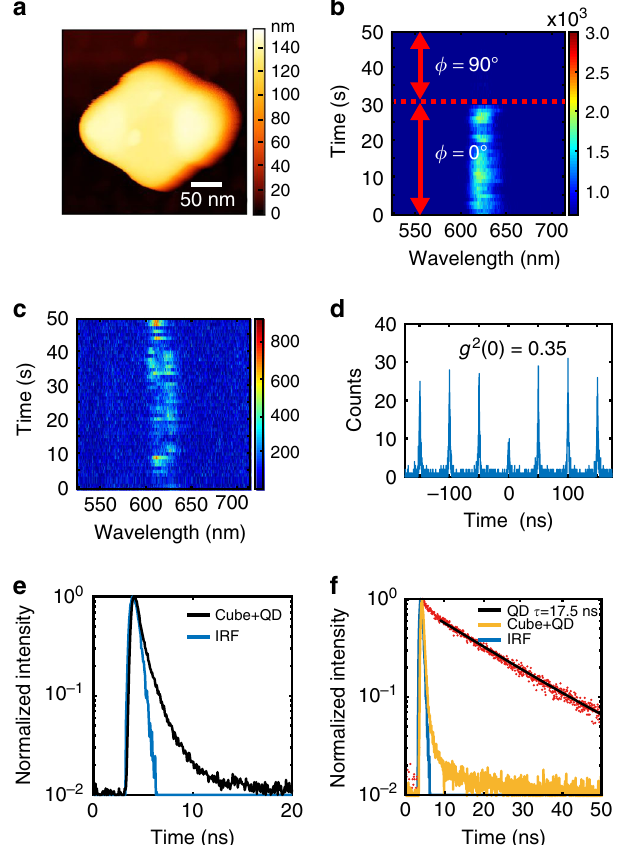
Fig. 8 Hybrid nano-emitters in the single photon regime. a AFM image of a nanocube-based hybrid nano-emitter. The polymer lobes contain a single or a few QDs. b , c PL spectrum time trace of t = 50 s excited by linearly polarized laser along ϕ = 0° at 405 nm. In b , at time t = 32 s, the polarization direction is rotated to ϕ = 90°. d g (2) measurement showing g (2) (0) = 0.35. e Typical lifetime measurement on a single-QD hybrid nano-emitter, lifetime ∼ 0.725 ns. The blue curve represents the instrumentation response function of 0.63 ns. f Lifetime measurements. Comparison between single QD in polymer without gold nanocubes (measure: red curve, fi tting: black curve 17.5 ns) and single QD in the vicinity of a gold nanocube (hybrid nano-emitter: yellow